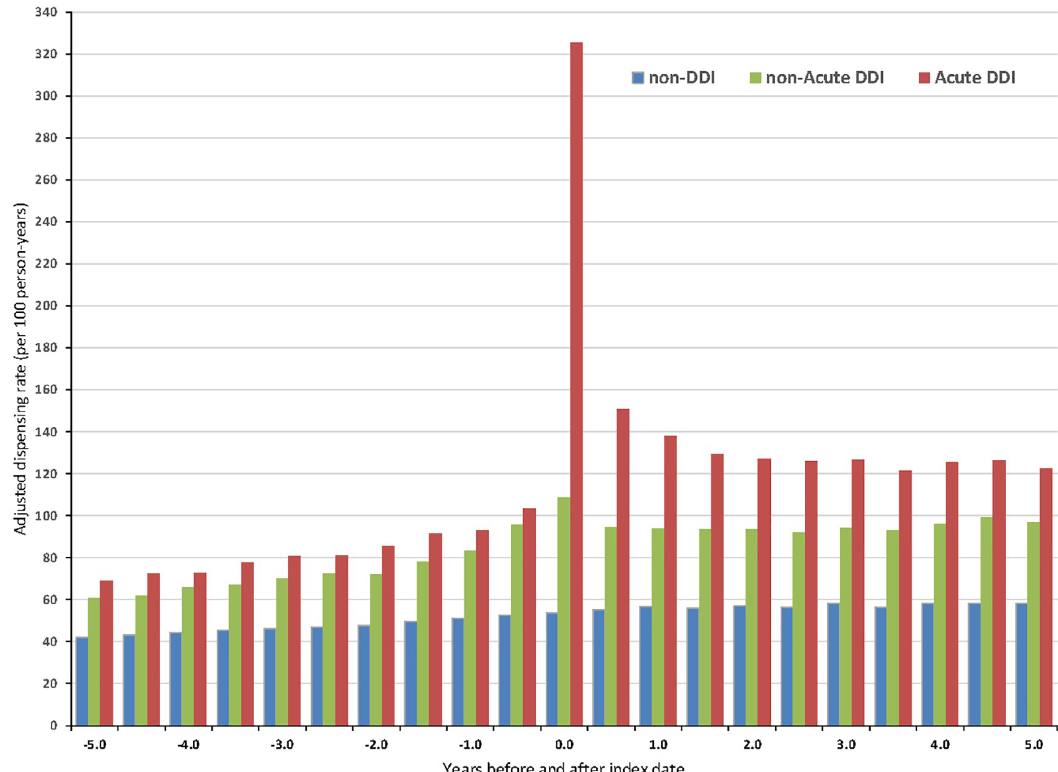
Fig 3. Dispensing rate of selected antibiotics before and after index date for diverticular disease of the intestine participants (n = 51,059: Acute DDI 20,880, non-acute DDI 30,179) and matched non-DDI participants (n = 510 581) during the period July 2007-June